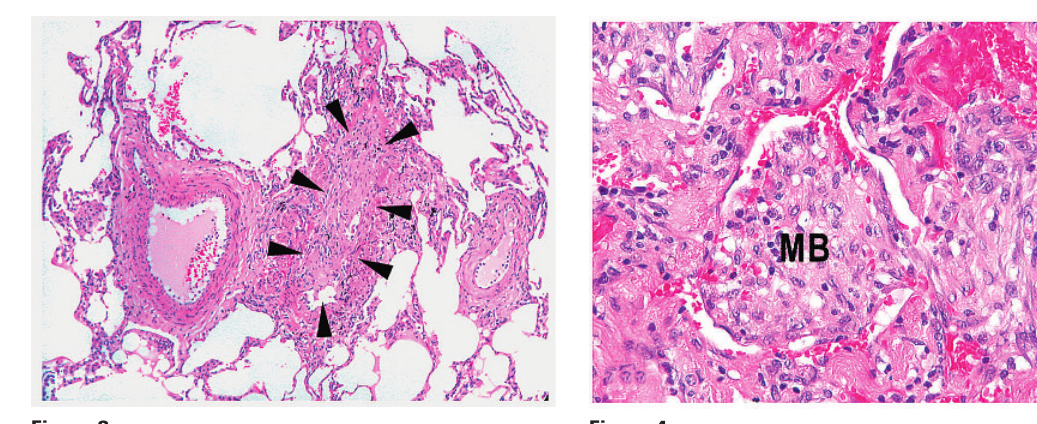
Focal organising pneumonia composed of Masson bodies (MB) (haematoxylin-eosin, magnification